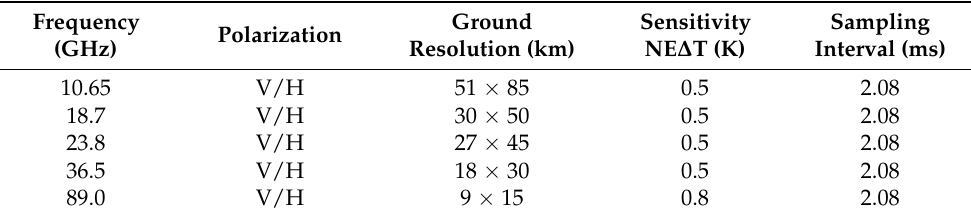
Table 1. Performance of the FY-3C MWRI.